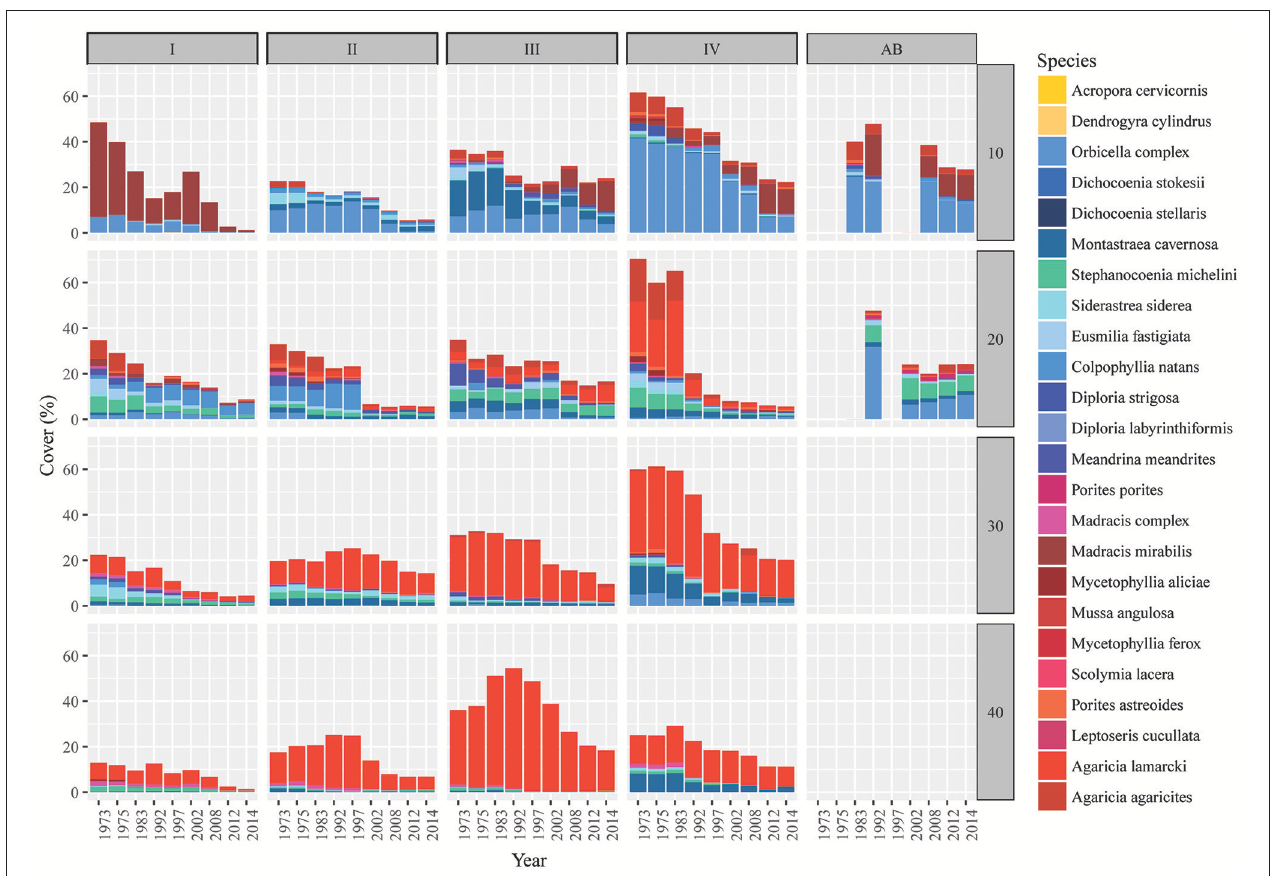
FIGURE 4 | Spatio-temporal dynamics in coral community composition on Curaçao and Bonaire. Bars represent the coral cover at surveyed points in time in the 9 m 2 quadrats. Bars are subdivided (stacked) by species. Competitive species are given in shades of yellow (virtually absent), framework building species in blue and opportunistic species in red/purple. Sites are listed as I-IV (main sites) and AB (reference site Awa Blancu) indicated along the top and the depths (10, 20, 30, and 40 m) given on the right side of the panel. Detailed characteristics per quadrat can be found in Tables S2,